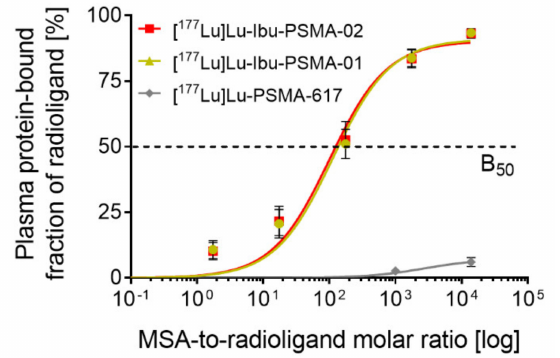
Figure 2. Data from ultrafiltration assays of [ 177 Lu]Lu-Ibu-PSMA-02 in comparison to [ 177 Lu]Lu-Ibu-PSMA-01 and [ 177 Lu]Lu-PSMA-617 ( n = 4). The data were fitted with a one-site specific binding curve to calculate the B 50 values. MSA: Mouse serum albumin. Data of [ 177 Lu]Lu-PSMA-617 were adapted with permission from Umbricht et al. 2018 Mol Pharm 15:2297 [16]. Copyright 2020 American Chemical